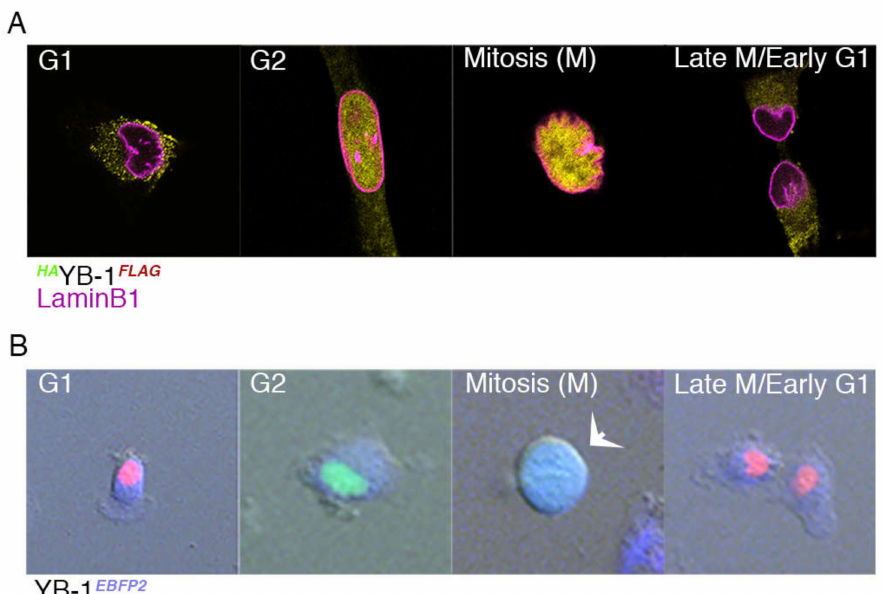
Figure 3. YB-1 translocates into the nucleus in the late G 2 phase of the cell cycle. ( A ) Mid z-stack slices (0.2 µ m) showing cellular location of HA YB-1 FLAG (yellow) in A549 cells. LaminB1 (magenta) marks the nuclear envelope. ( B ) Illustrates the cellular location of YB-1 eBFP2 in di ff erent phases of the cell cycle in A549 FUCCI cells transfected with YB-1 eBFP (blue); G 1 marked by cdt1(red), S / G 2 marked by